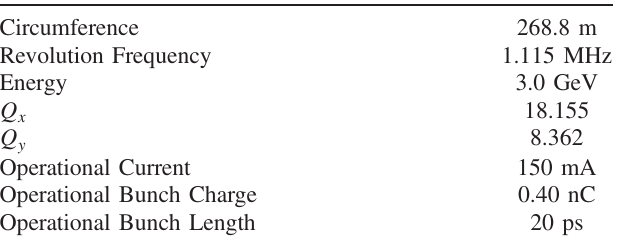
TABLE I. ALBA storage ring main